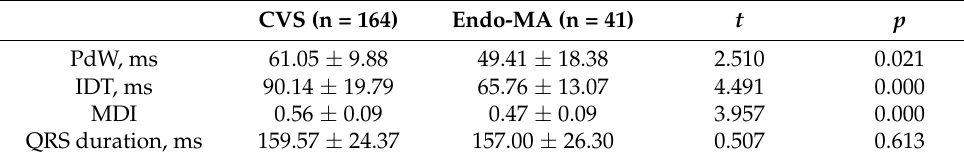
Table 5. Comparison ECG characteristics of IVAs originating from the endo-MA.